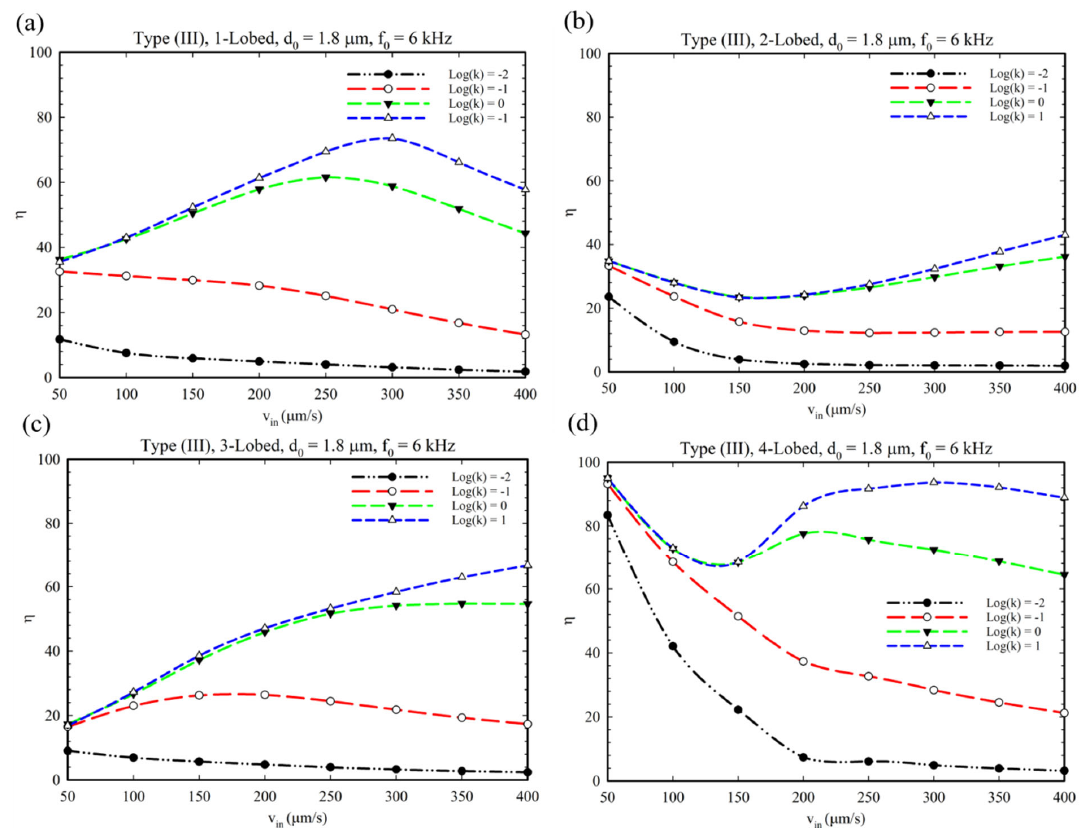
Figure 12. Production efficiency at different fluid velocities for type (III) microchannels with the geometries of ( a ) 1 ‐ lobed, ( b ) 2 ‐ lobed, ( c ) 3 ‐ lobed, and ( d ) 4 ‐ lobed structures.